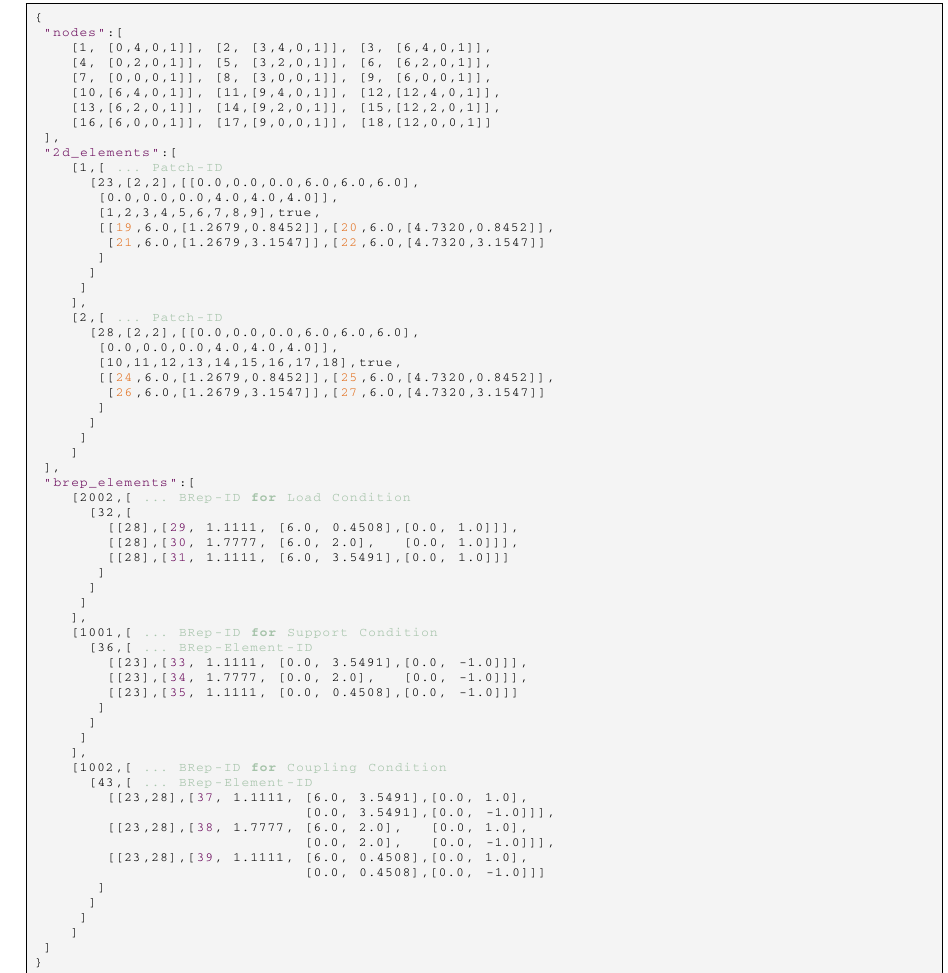
Listing 11 Example two-patch model: the IBRA exchange format provides the data for the geometry in Fig. 22